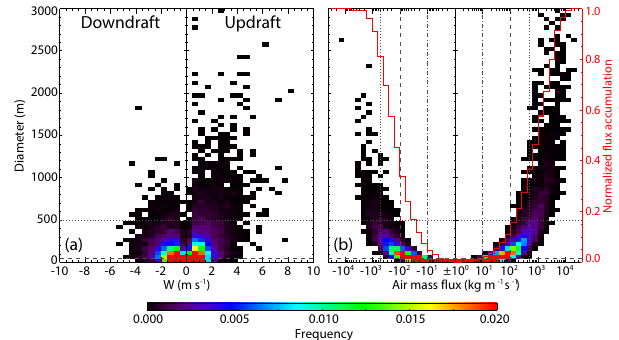
Figure 5. Occurrence distributions as (a) a function of diameter and mean vertical velocity and (b) a function of diameter and air mass flux for all updrafts and downdrafts. The normalized accumu- lation flux is also shown by the red curves. The horizontal dotted and dashed lines in (a) and (b) indicate the draft diameter equal to 500 and 50m, which are used as the diameter thresholds to identify a “draft” in previous studies and in this study, respectively. The ver- tical dash-dotted, dashed, and dotted lines in (b) indicate air mass flux equal to 10, 100, and 500kgm − 1 s − 1 in magnitude, respec- tively, which are the thresholds used to delineate the three different groups of